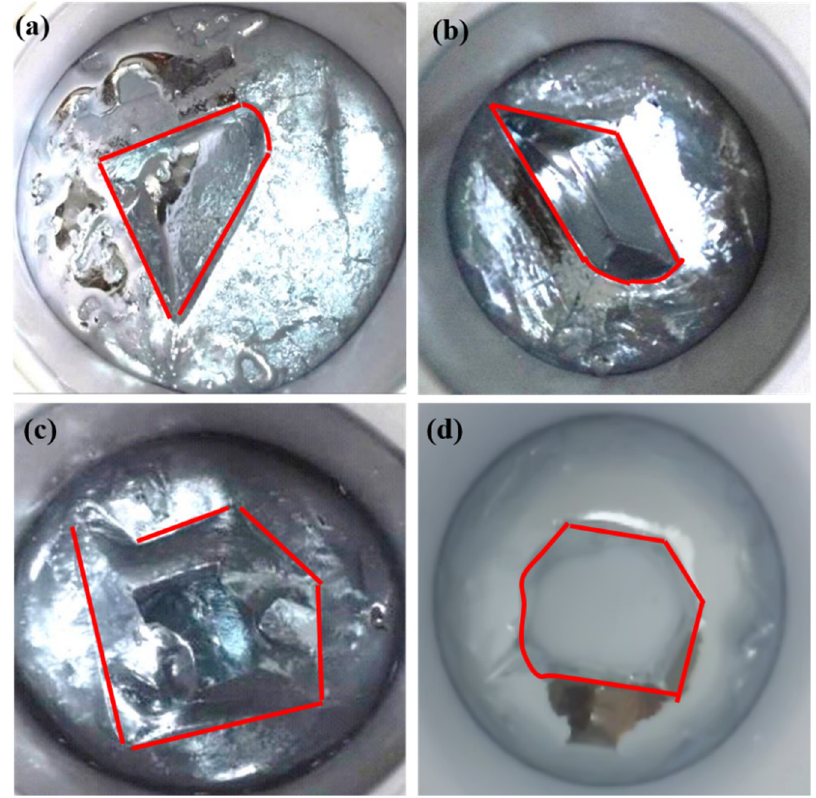
Figure 6. Photographs of crystal morphology when adding different numbers of seeds (( a ) 3, ( b ) 4, ( c ) 5, and ( d ) 6).